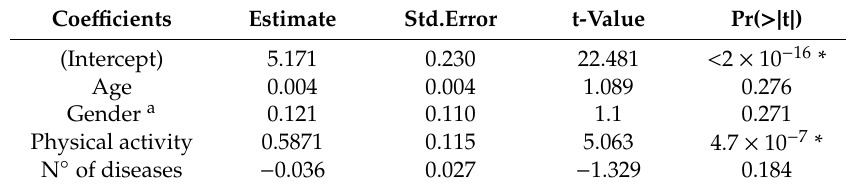
Table 3. Regression models with Resilience as the dependent variable: Model 1a (physical activity). Coe ffi cients Estimate Std.Error t-Value Pr( >| t | ) (Intercept) 5.171 0.230 22.481 < 2 × 10 − 16 * Age 0.004 0.004 Gender a 0.121 Physical activity 0.5871